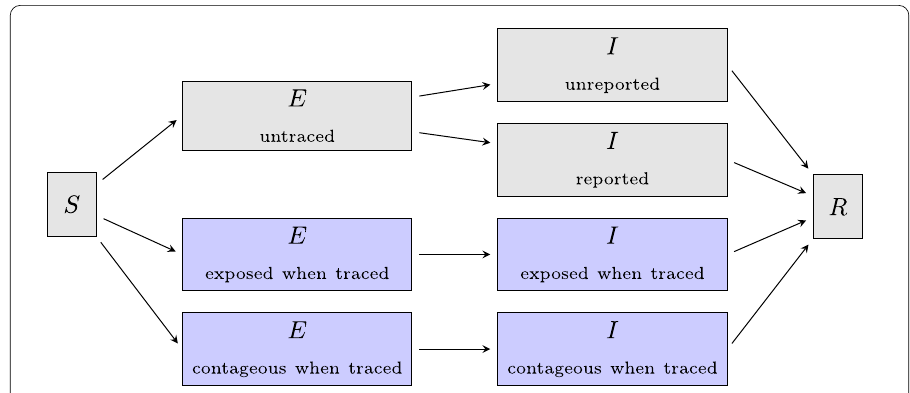
Figure 4 Simplified structure of the compartmental model. The model is based on a SEIR-type model from Ref. [58] and distinguishes between untraced (gray) and traced (blue) individuals. A detailed description of the model and its variables can be found in Appendix